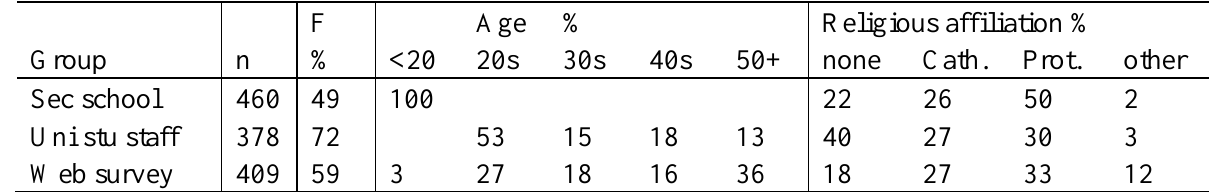
Table 1. Distribution of samples in three studies with the